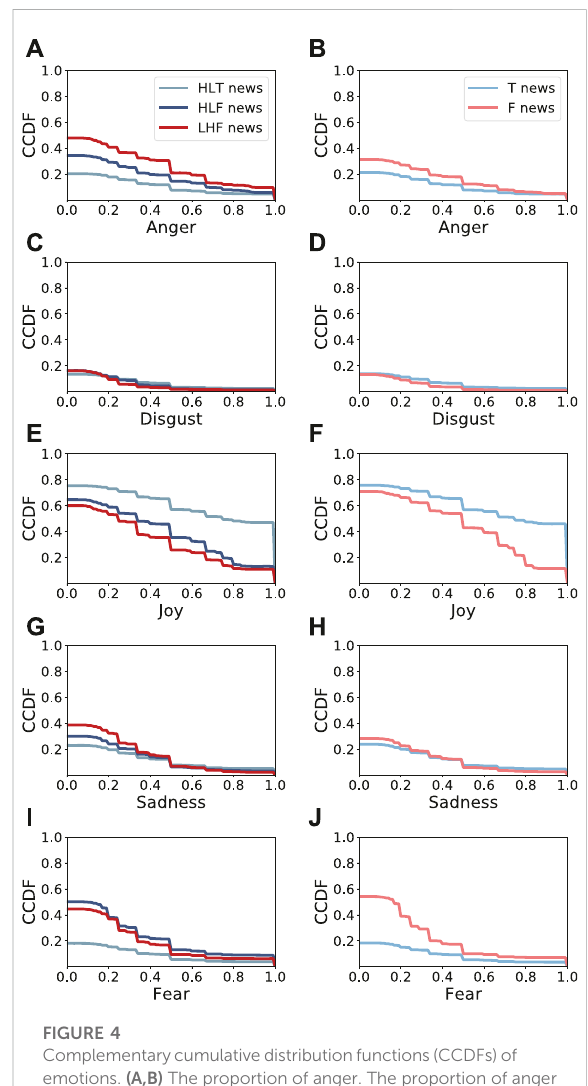
FIGURE 4 Complementarycumulativedistributionfunctions(CCDFs)of emotions. (A,B) The proportion of anger. The proportion of anger greater than 0.5 in LHF news is nearly 3 times as much as that in HLT news (C,D) The proportion of disgust. (E,F) The proportion of joy. The proportion of joy greater than 0.5 in HLT news is more than 2 times as much as that in LHF news (G,H) The proportion of sadness. (I,J) The proportion of fear. The results of K-S tests are shown in Supplementary Material S5, and consistent results from other methods can be seen in Supplementary Material